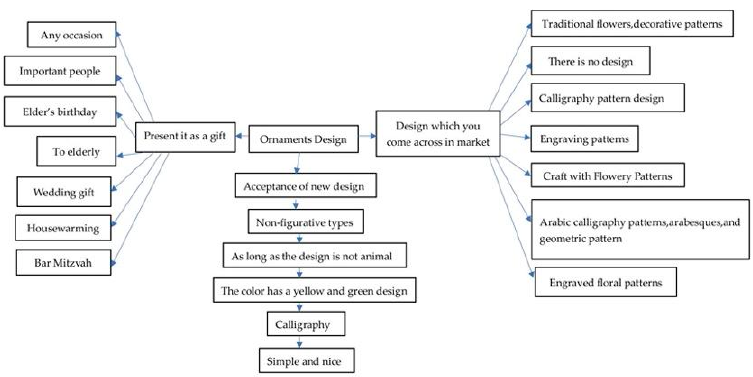
Figure 6. Atlas-ti network view of the surface design of the rehal. Table 4. Analysis of interview content of Question 3.